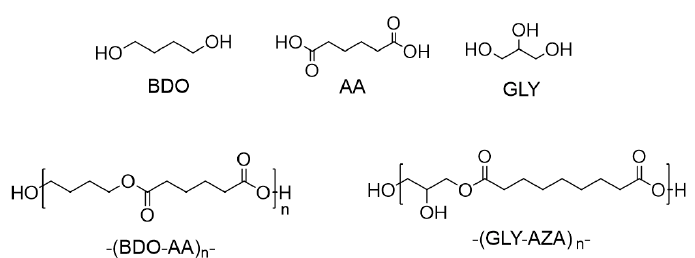
Figure 1. Structure of the bio-based monomers and the corresponding bio-based oligoesters obtained by enzymatic polycondensation. Codes refer to marine biodegradation tests.